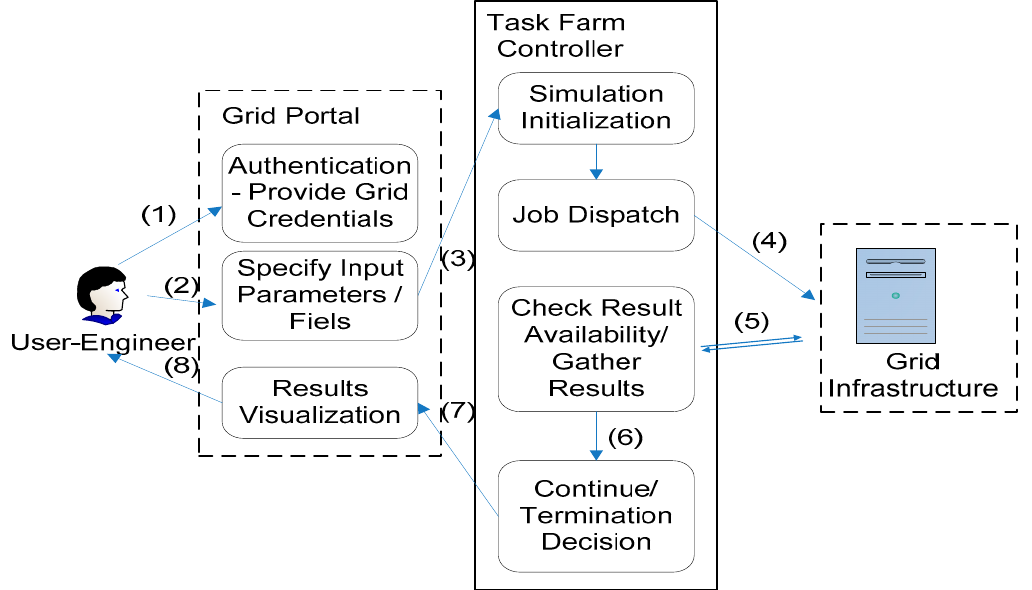
Figure 5. Grid flow for independent MC (Monte Carlo) simulations.